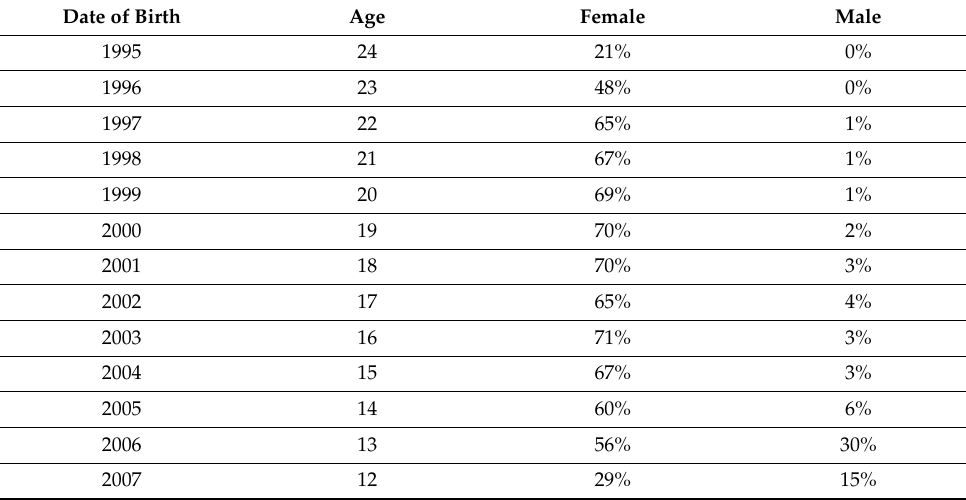
Table 4. Percentage of population fully vaccinated for high-risk HPV stratified by age and